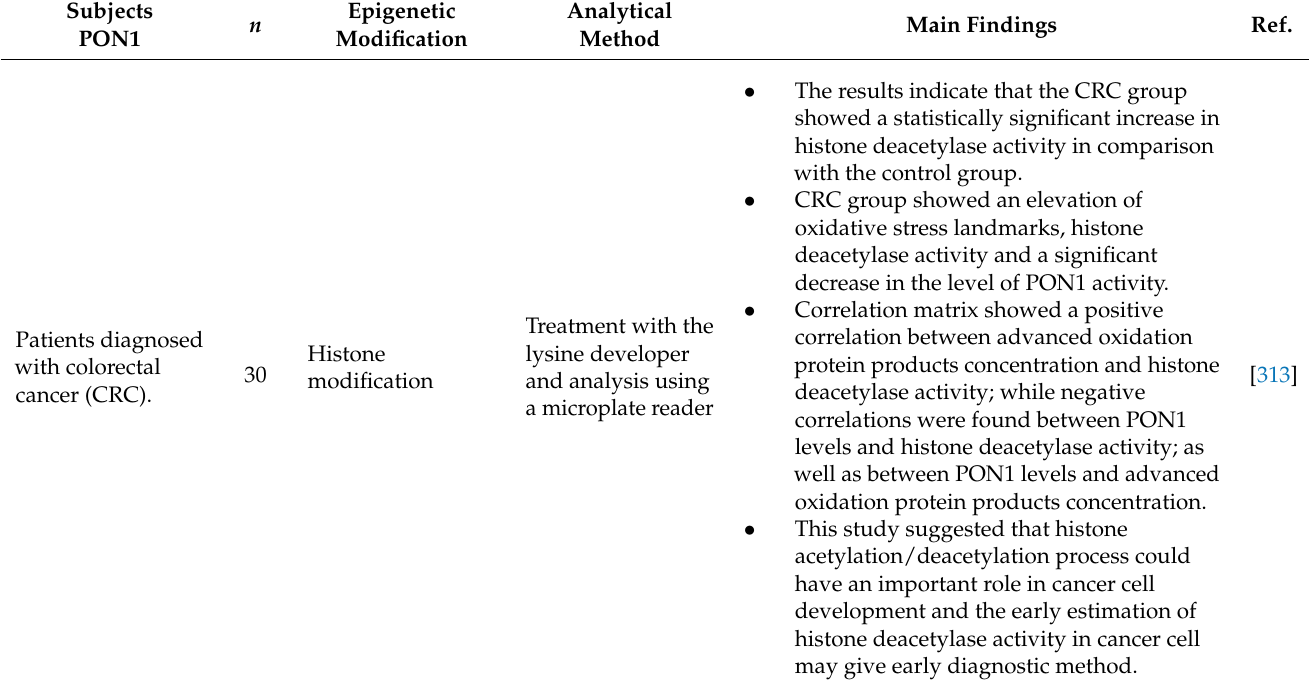
Table 3. Epigenetic modifications focused on PON1 studies and cancer development. Main Findings